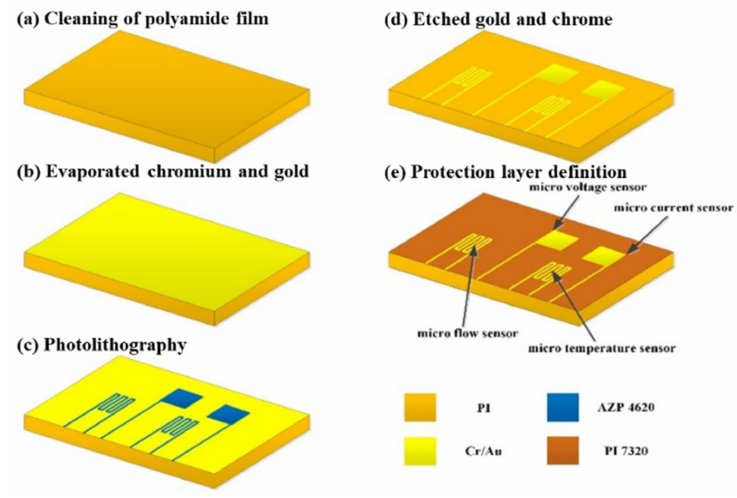
Figure 2. Process diagram of the flexible, multifunctional